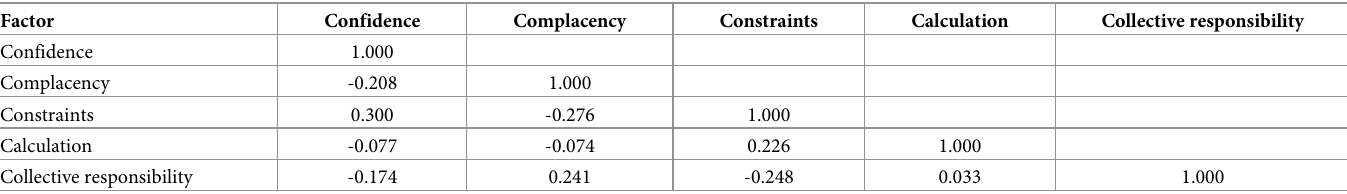
Table 4. Factor correlation matrix of the Arabic version of the 5C scale.